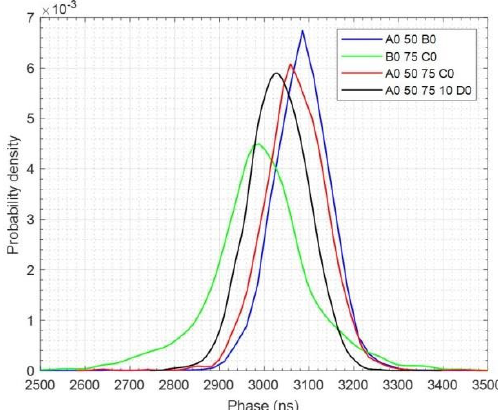
Figure 20. Distribution density with two LEMs.